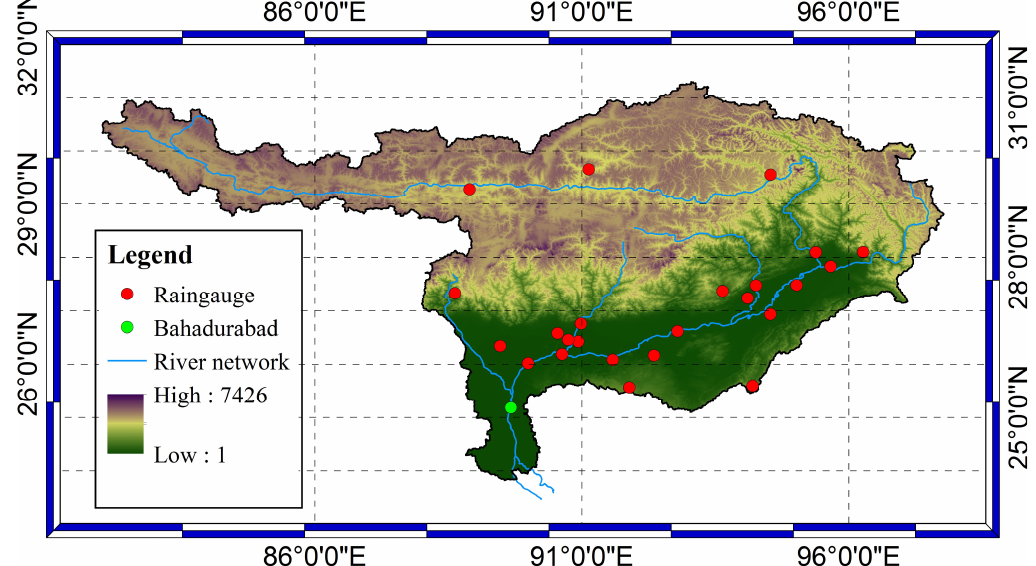
Figure 1. Topographic map of Brahmaputra Basin along with the location of rain gauges and the outlet of the basin